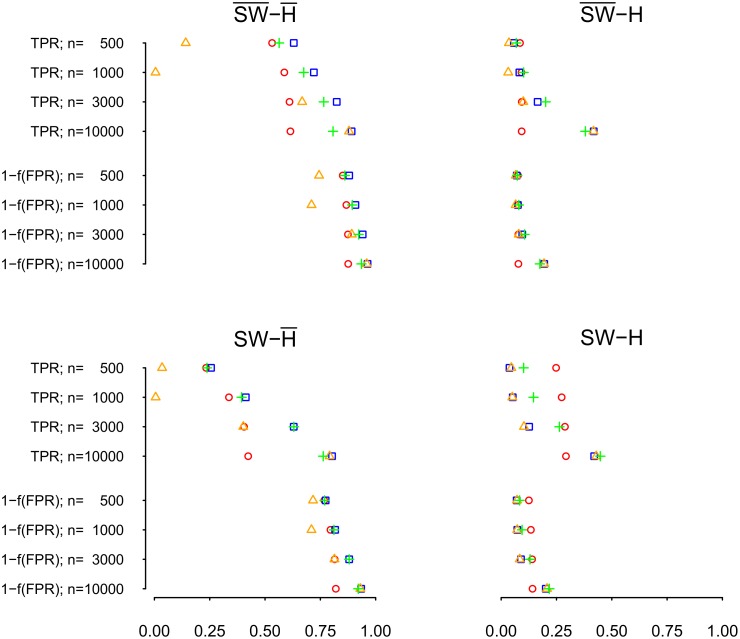
Overview of TPR and of 1 − f(FPR) for shrinkage (blue), ridge (orange), and lasso (green) estimated partial correlations, and for pairwise correlations (red), averaged over all three selection criteria (i.e., correct number of edges, 20% less edges, and 20% more edges).
f(FPR) = exp(−102*FPR); n = Number of observations.